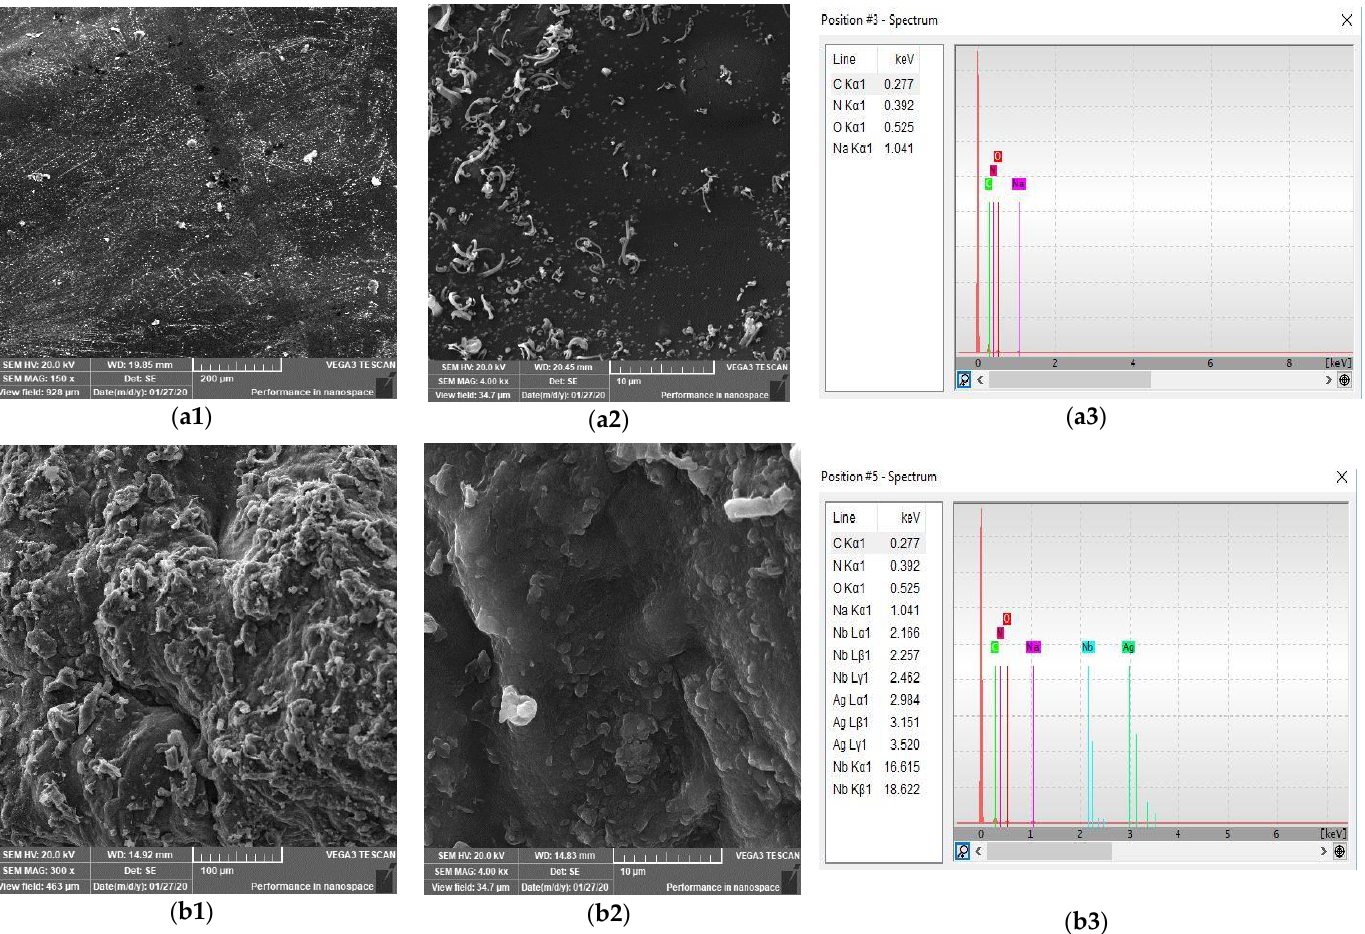
Figure 5. SEM images of chitosan hydrogel ( a1 , a2 ), chitosan/Ag –curcumin hydrogel ( b1 , b2 ) and their EDX spectra of chitosan hydrogel ( a3 ) and chitosan/Ag-curcumin hydrogel ( b3 ).